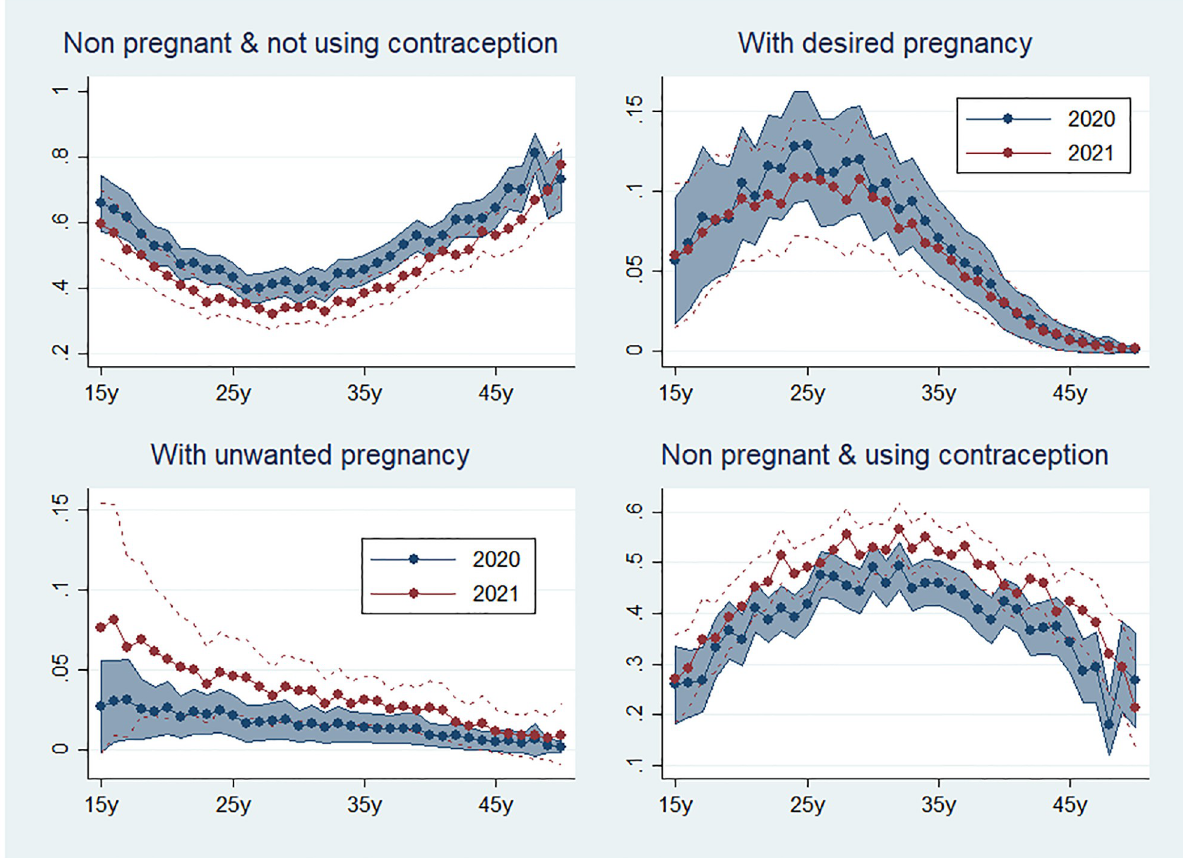
Fig 4. Women’s predicted probabilities in 2020 and 2021 of being (i) non pregnant and not using contraception; (ii) intentionally pregnant; (iii) unintentionally pregnant and; (iv) non pregnant and not using contraception, by age. Predicted probabilities are derived from a multinomial model adjusted for age, education, parity, marital status, household size, socioeconomic status, area (urban vs. rural) and location of the household, with robust variance estimators. The red line represents the 2021 prediction, with the 95% confidence interval delimited by the red dotted lines. The blue line represents the 2020 prediction, with the 95% confidence interval delimited in the blue-shaded area.